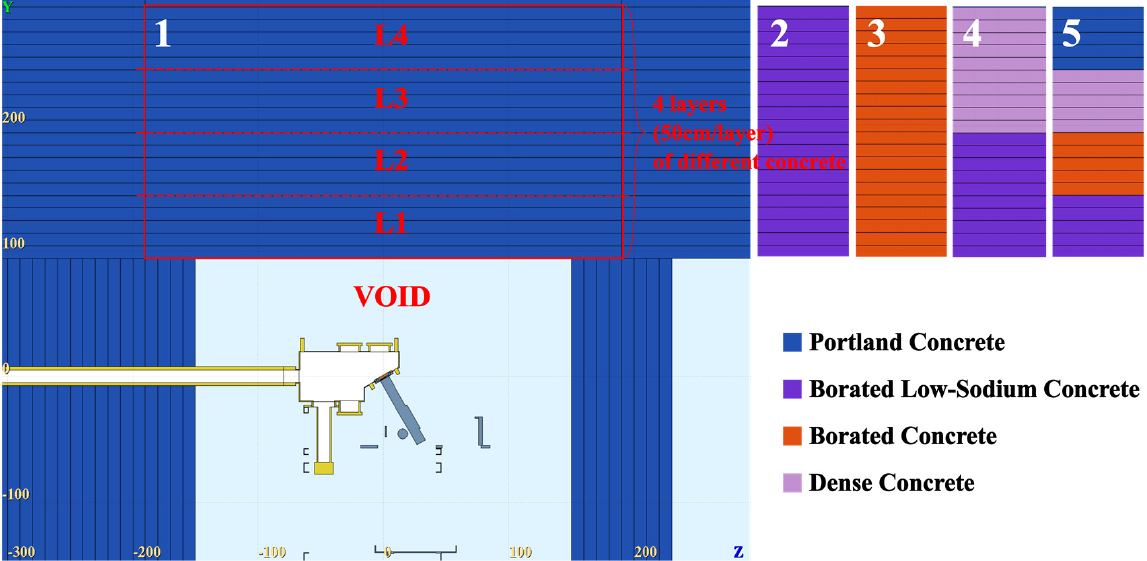
Figure 9. Five combinations of shielding materials (Portland concrete, borated low-sodium concrete, borated concrete, and dense concrete) in the top shielding, which are filled from L1 to L4. Distances are given in cm.